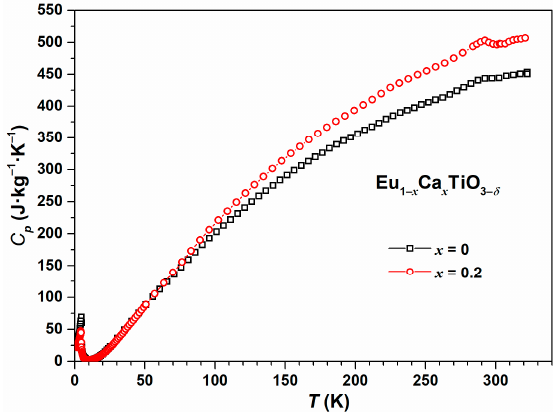
Figure 1. Low-temperature heat capacity measurement of EuTiO 3– δ (black) and Eu 0.8 Ca 0.2 TiO 3– δ (red) using the physical properties measurement system (PPMS).